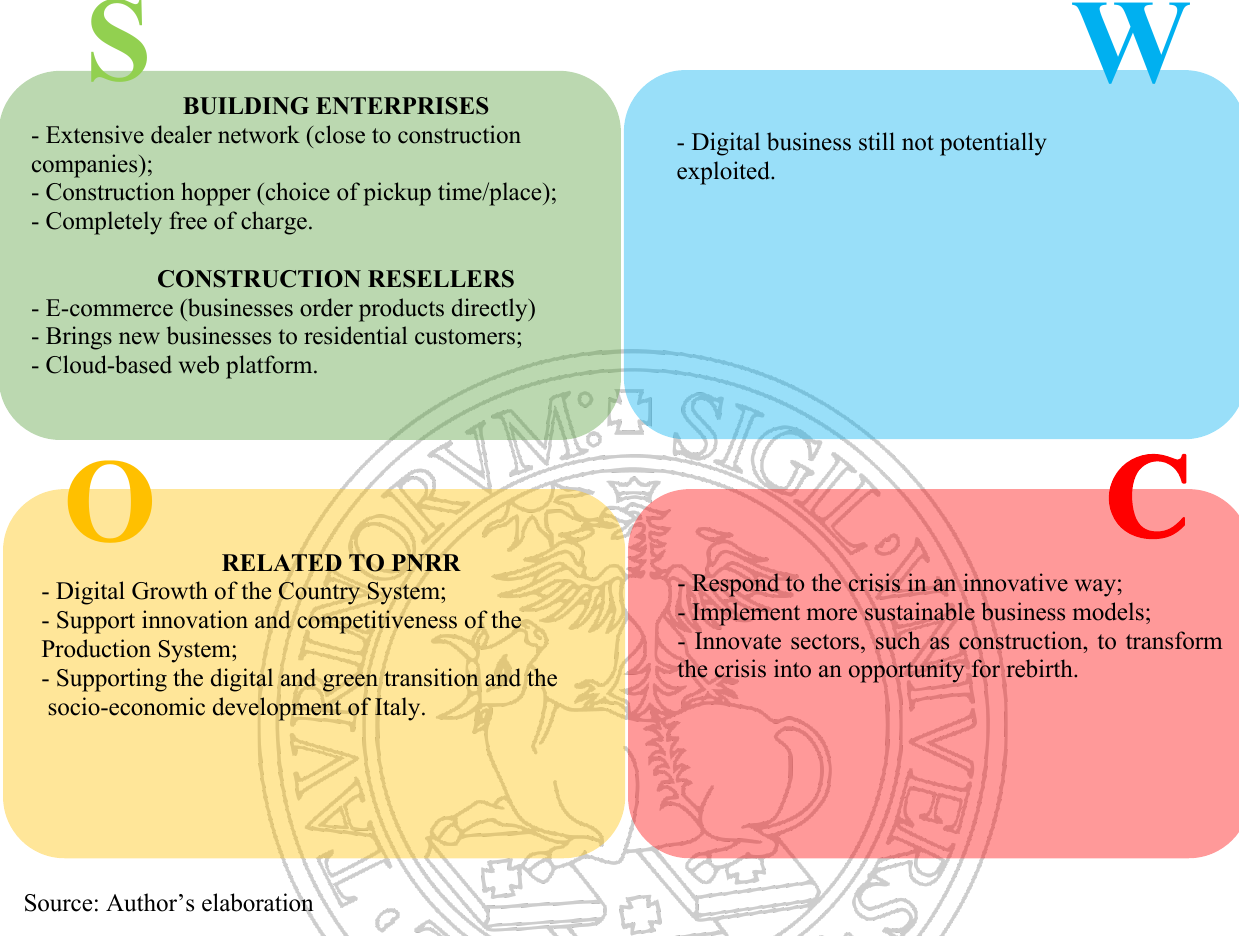
Figure 1. “S.W.O.C